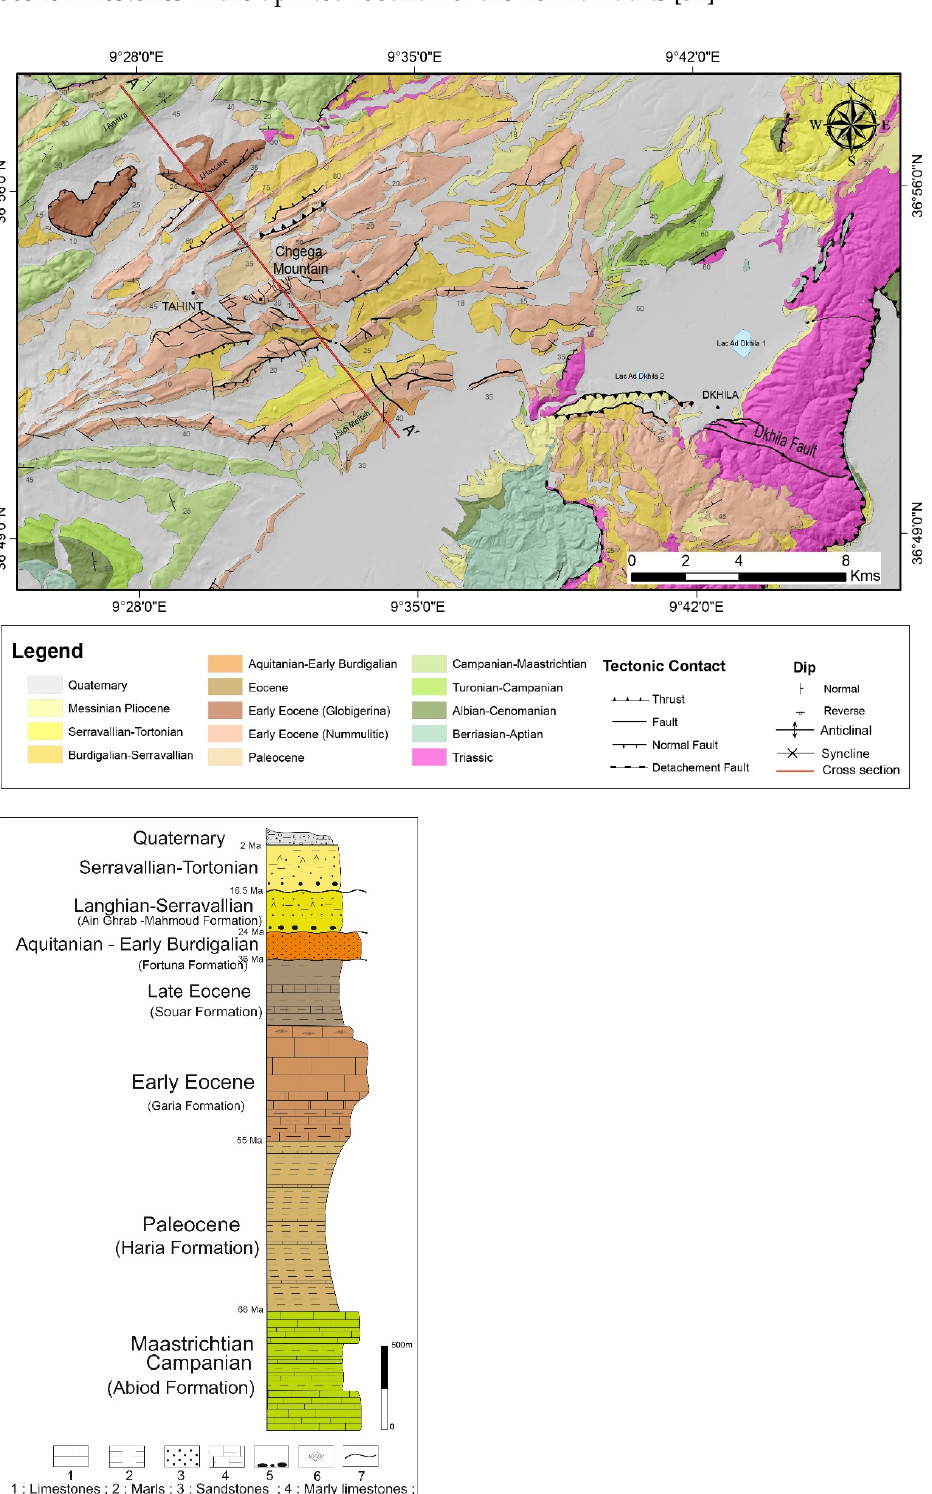
Figure 3. NW-SE cross-section highlighting the main structures of the study area (AA’). Position of AA’ is given in Figure 2. Since the Late Pliocene topographic incision and rejuvenation in Northern Tunisia, the landscape evolution is mostly driven by NW-SE directed tectonic shortening, accom- modated along reverse and strike-slip faults and associated folds, which favor the devel- opment of incipient transverse drainage through recent fluvial captures [15,28]. This active tectonic shortening is the cause of damaging earthquakes—the 410 AD Utique and the 856 AD Tunis seismic events—related to the activity of the Alia-Thibar fault system [36,37]. The maximum observed seismic intensity maps for Tunisia indicate higher intensity registered in the proximity of the western end of the fault system, near the village of Thibar [38]. The seismic hazard map of Tunisia indicates the highest hazard in the region near Tunis, including our studied area [39] (Figure 4). The Chgega landslide